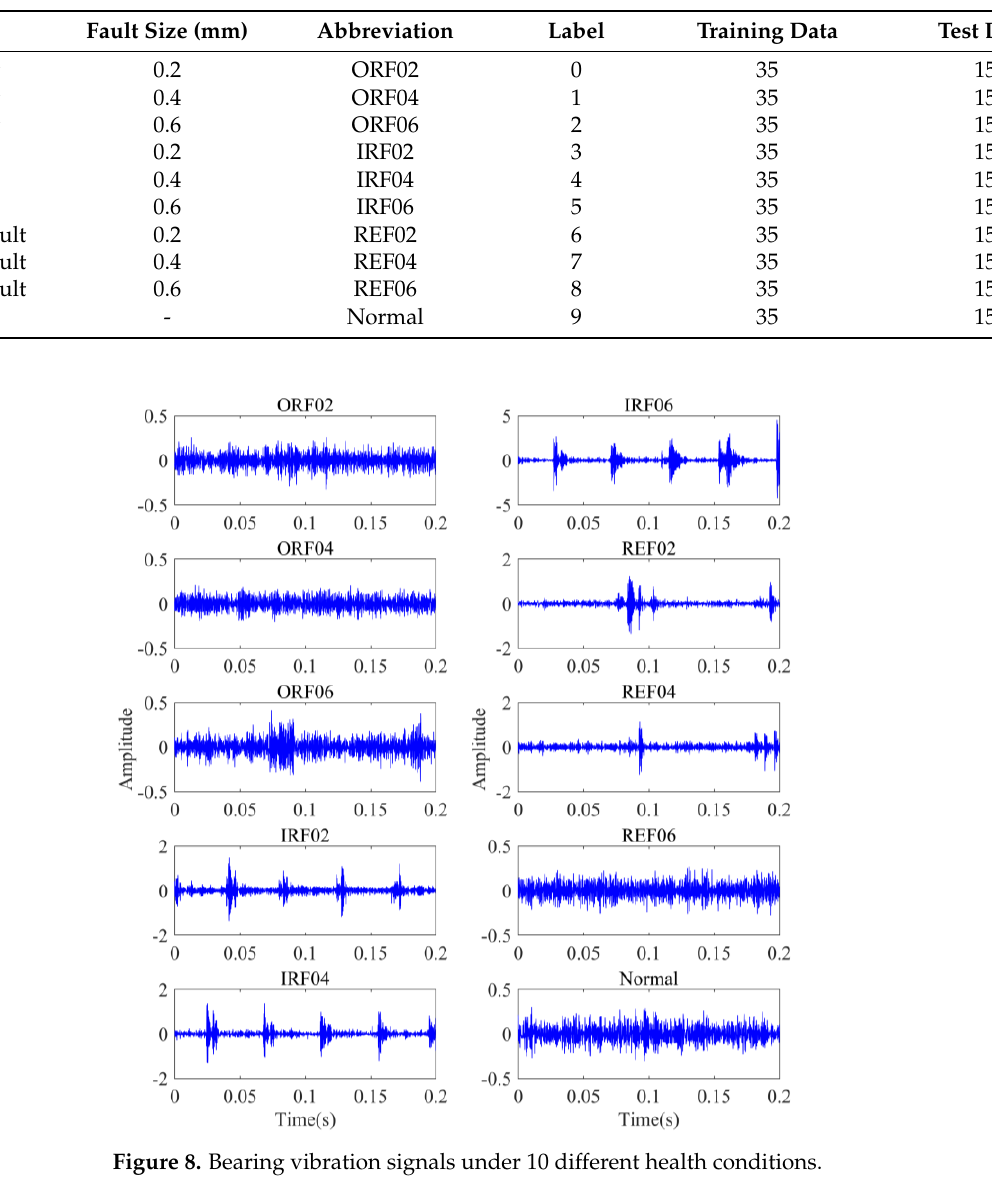
Table 4. The description of experimental data.